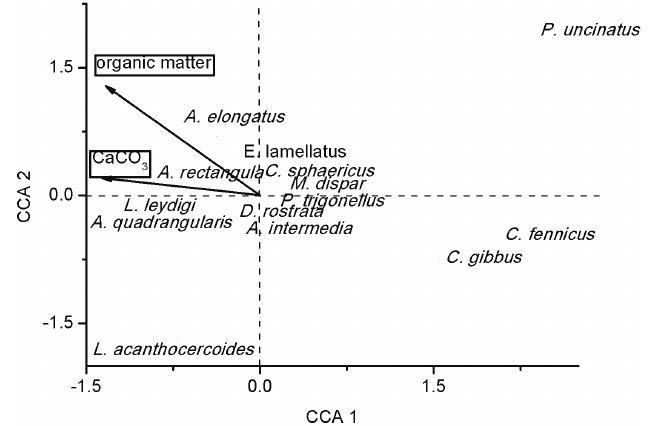
Figure 5. CCA ordination of benthic Cladocera taxa and sediment parameters.